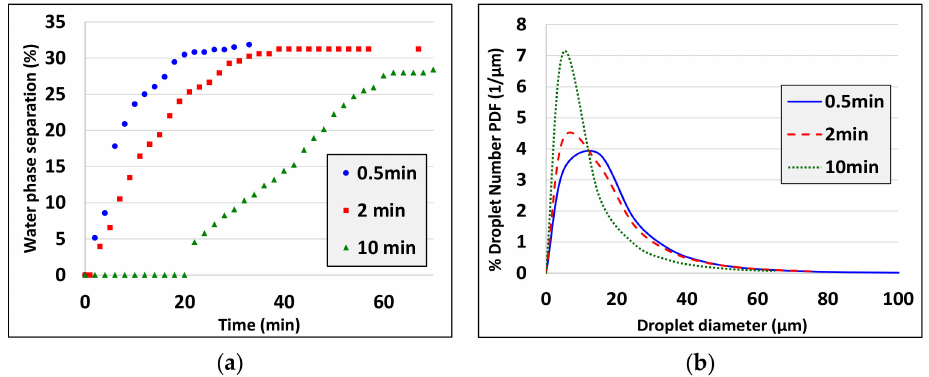
Figure 7. E ff ect of nominal emulsification time t n on ( a ) water phase separation and ( b ) droplet size distribution of emulsions (C SDS = 1 CMC, ϕ = 0.5 and f = 10 Hz; Piston 1, 0.5 min: d av = 16.2 µ m, 2 min: